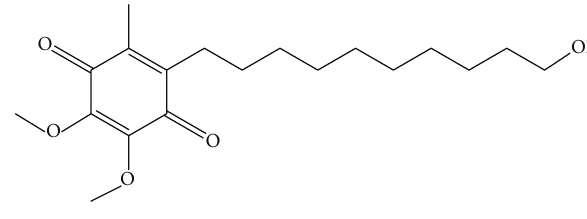
Figure 1: Chemical structure of